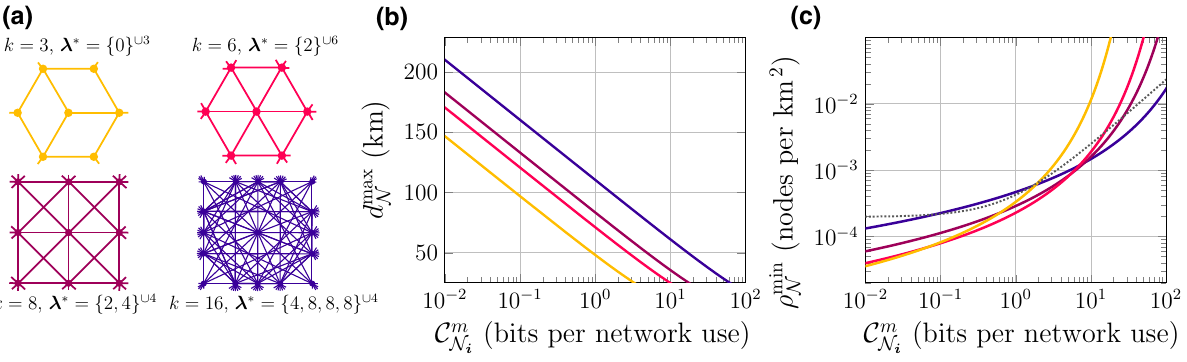
FIG. 2. (a) Examples of network cells that can be used to construct quantum WRNs, where k denotes regularity and λ ∗ is the adjacent-commonality multiset that minimizes the quantity in Eq. (11). These quantities characterize the network cell and larger WRNs that they can construct. (b) The relationship between the optimal end-to-end flooding capacity (equal to the min-neighborhood ) and the maximum link length d max N required to guarantee it for bosonic lossy quantum networks according to Eq. (12). capacity C m N i The plots are color coordinated with the network cells. Greater network regularity leads to larger permissible ranges of channel lengths. (c) This relationship is depicted between minimum nodal density ρ min N with respect to optimal performance for bosonic lossy quantum networks, color coordinated with the network cells. The gray dotted line relates the nodal density to the average flooding capacity between any pair of nodes in a Waxman network, as in Eq. (18)